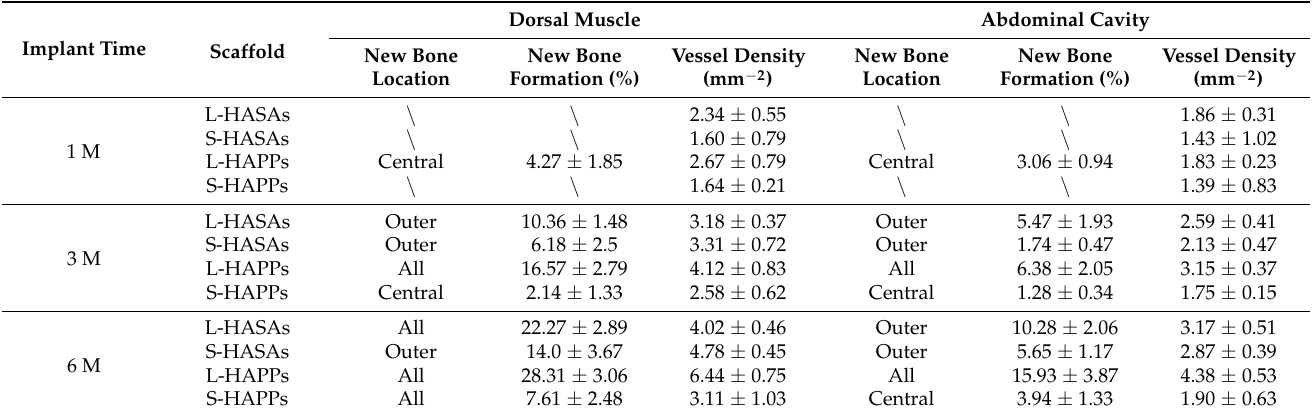
Table 1. Histological summary of ectopic bone formations of HA porous scaffolds implanted in dorsal muscle and abdominal